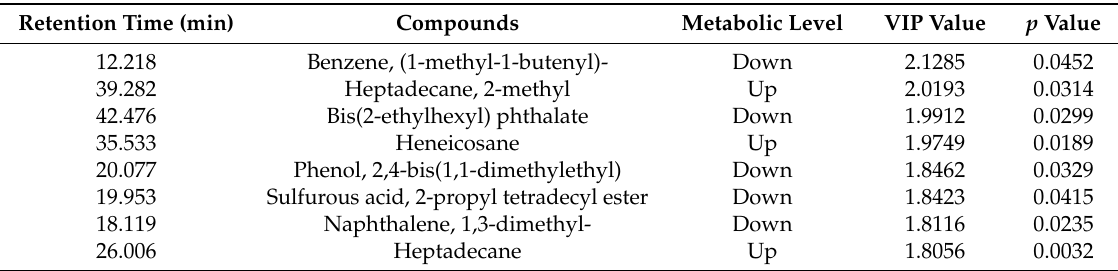
Table 3. The differently abundant metabolites from HN48 root exudates under different continuous- cropped year soil in potted-experiments.